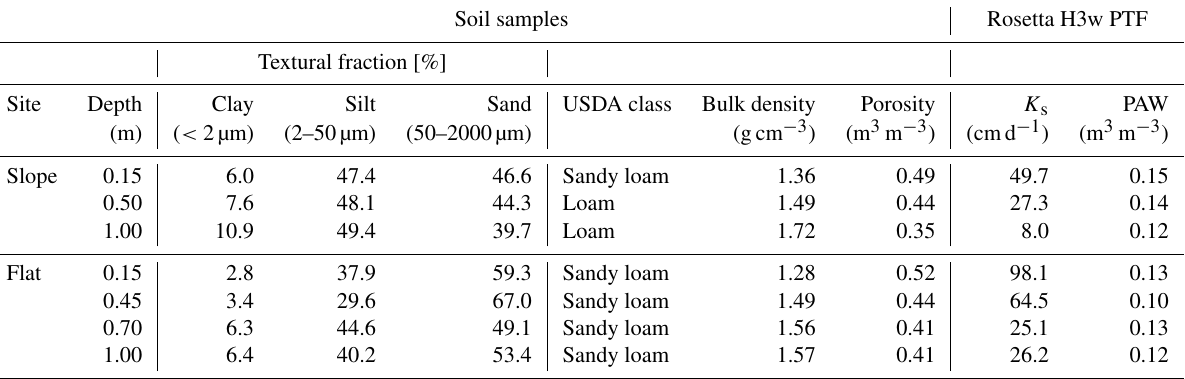
Table 2. Soil properties of the soil samples collected at the two monitoring sites and textural splits according to the USDA taxonomy as well as soil hydraulic properties derived by the Rosetta H3w pedotransfer function (Zhang and Schaap, 2017). PTF: pedotransfer function, PAW: plant-available